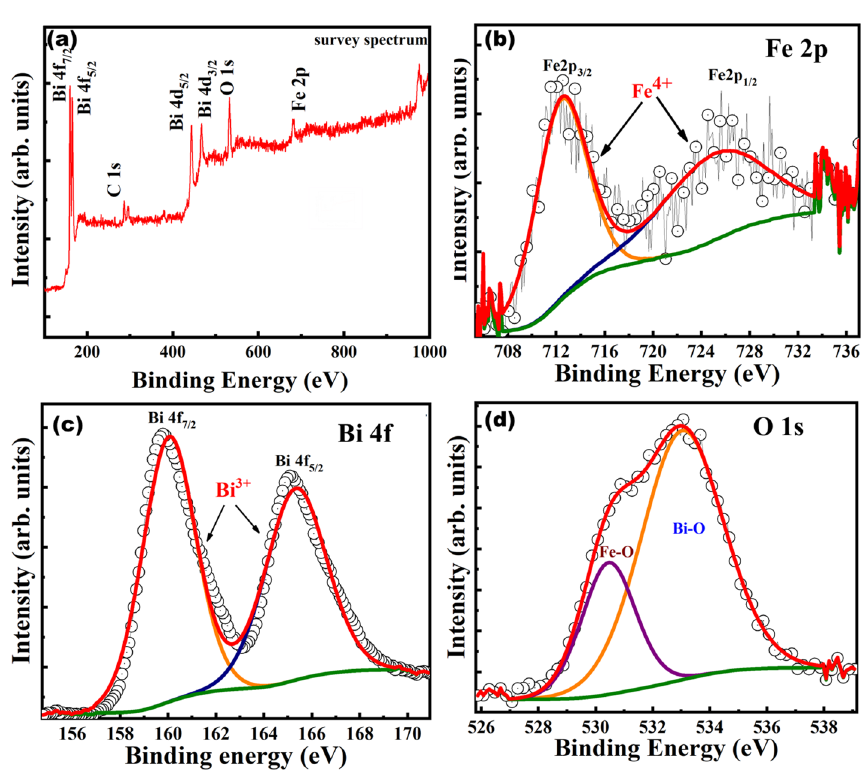
Figure 4. XPS spectra of ( a ) full survey spectrum, ( b ) Fe 2p, ( c ) Bi 4f. and ( d ) O 1s spectra of as synthesized BFO